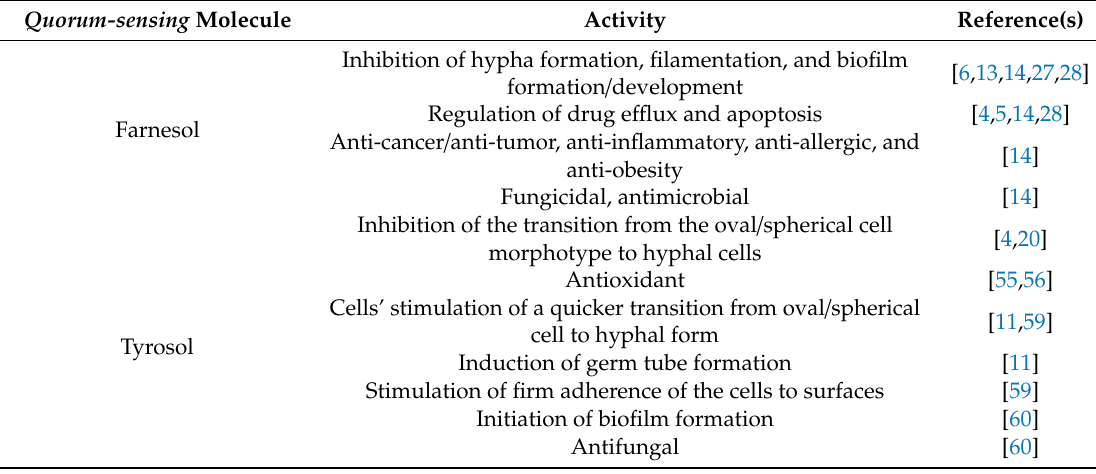
Table 1. General Far and Tyr roles in